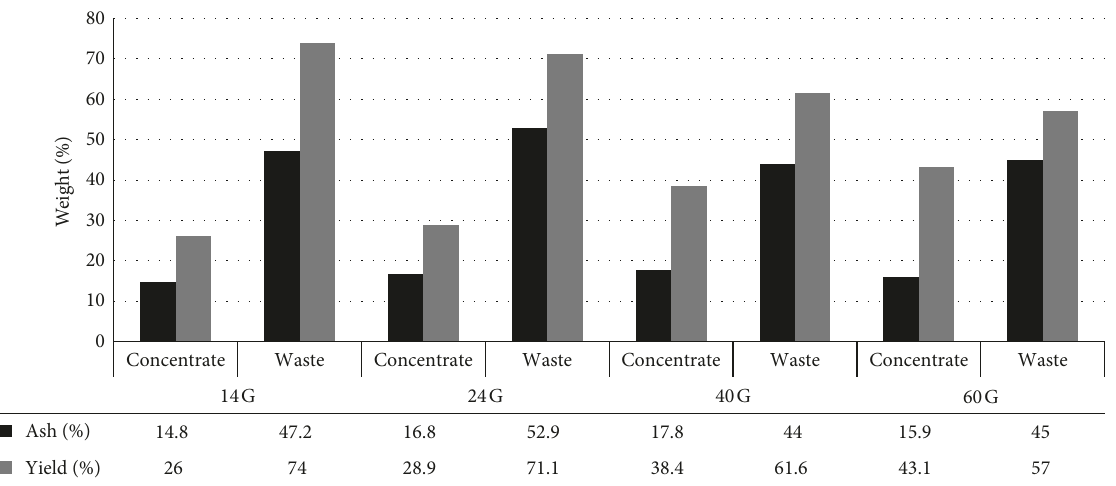
Figure 5: Enrichment concentration graphic of Sample-C1 coal with Knelson method (